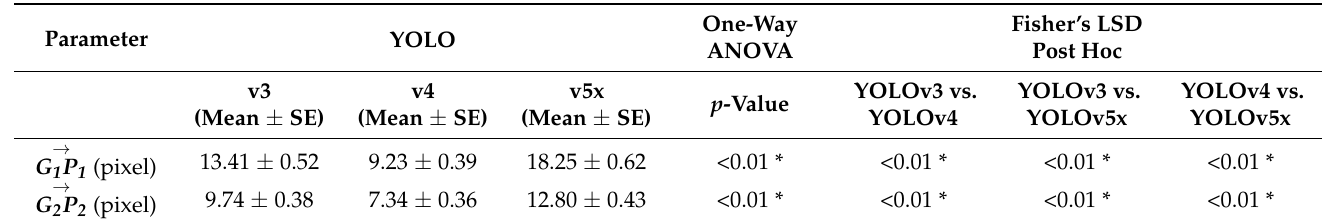
Table 3. Effect of different YOLO models on the distance between the ground-truth point and prediction point.